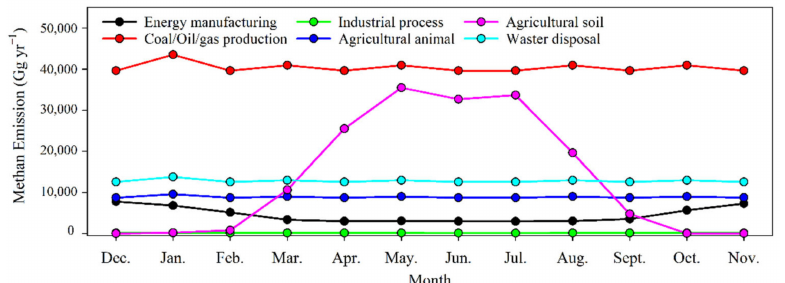
Figure A3. Spatial distribution of the annual rate of increase in methane emission of six cate- gories from EDGAR over China during 2003–2018 (mg m − 2 a − 1 ). ( a ) Energy manufacturing; ( b ) coal/oil/gas production; ( c ) industrial process; ( d ) agricultural animal (including enteric fermen- tation and manure management); ( e ) agricultural soil (including rice cultivation and field burning of agricultural residues); ( f ) waste disposal.